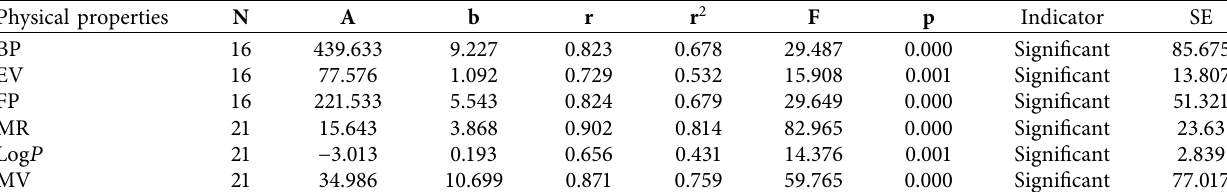
Table 8: Statistical specifications for the linear model of ABC ( G ) .